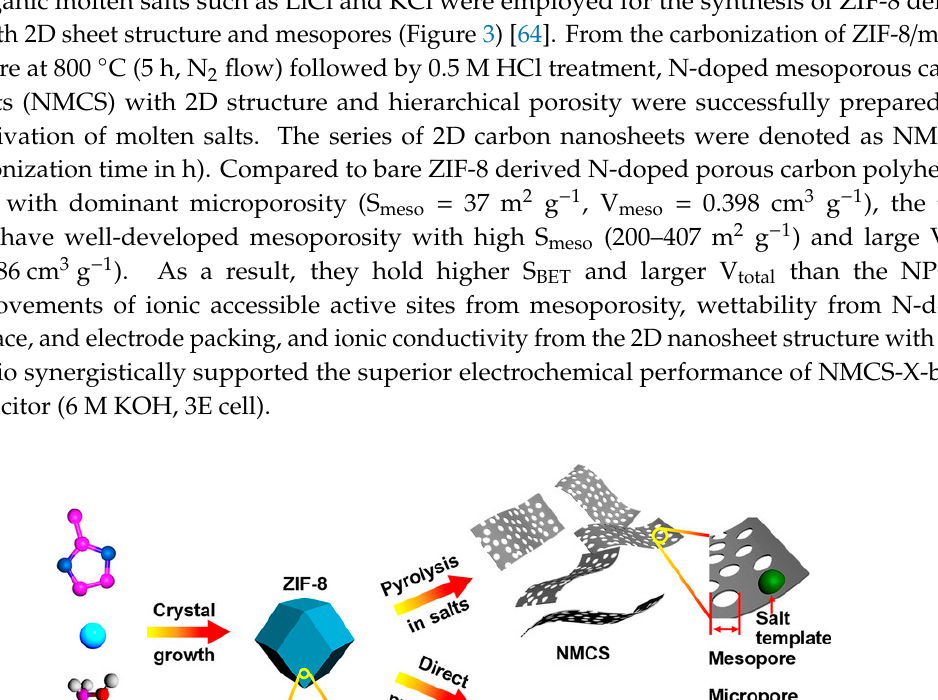
Table 3. The electrochemical capacitive performances of porous carbons derived from other ZIF- based Zn-MOFs.